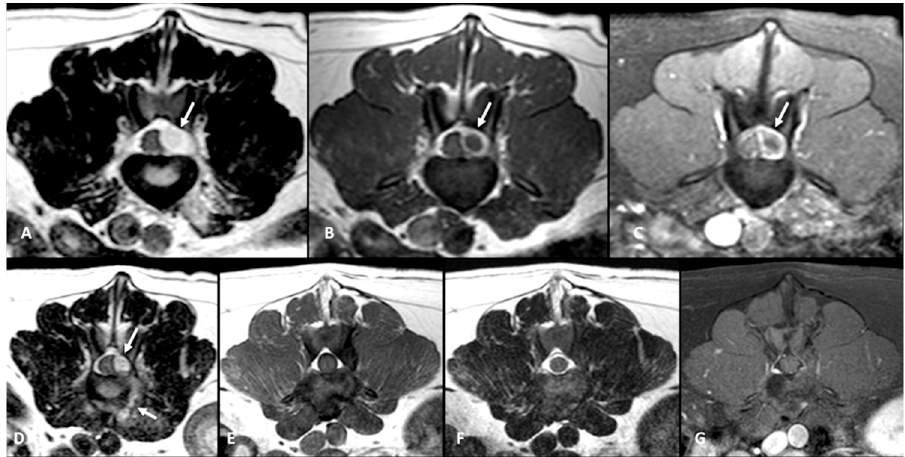
Figure 3. MRI transverse planes T2-W ( A ), postcontrast T1-W ( B ), and postcontrast fat-saturated T1-W ( C ) of the same dog as Figure 2, showing a left dorso-lateral epidural space-occupying lesion (arrows) in the L3–L4 intervertebral level with severe spinal cord compression. Transverse T2-W image of the same dog at L4–L5 ( D ) also demonstrates an infiltrative lesion that extends through the left intervertebral foramen (lower arrow) in connection with the epidural lesion (upper arrow). Follow-up transverse T1-W ( E ), T2-W ( F ) and postcontrast fat-saturated T1-W ( G ) images at 4 months after surgery depict the resolution of the infiltrative foraminal and post-foraminal lesions and of the epidural.